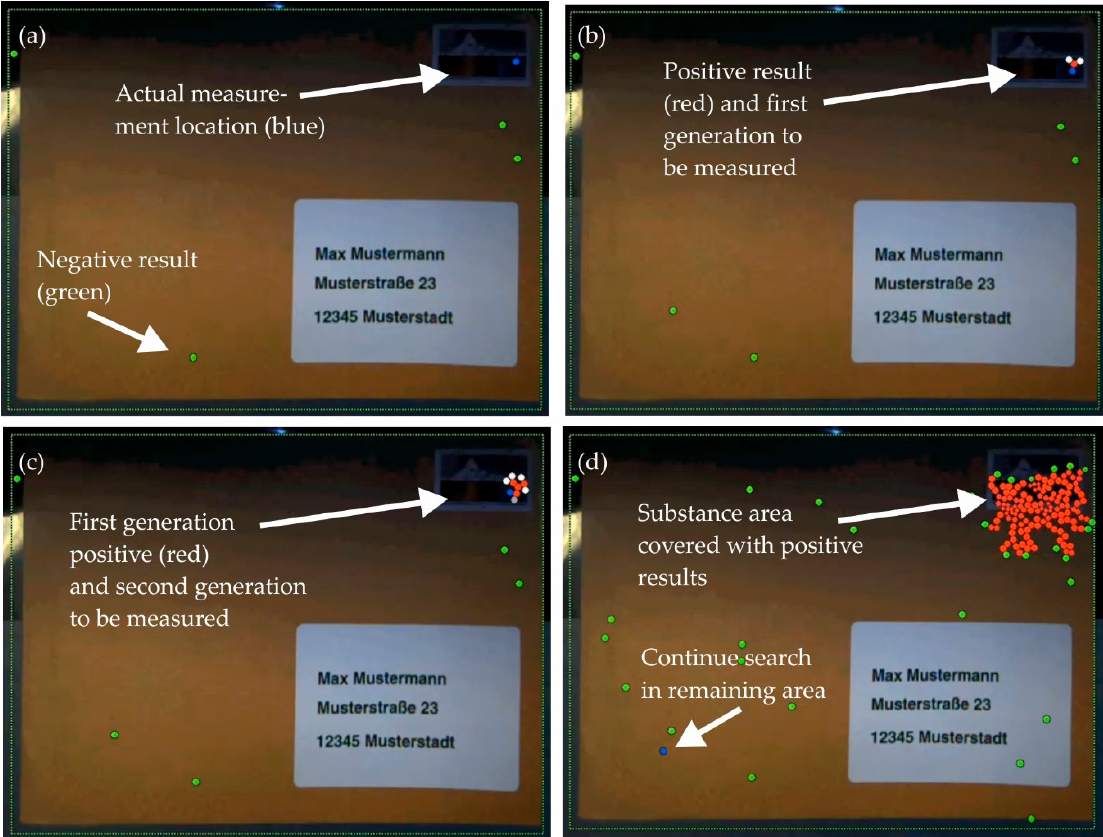
Figure 11. Procedure of result dependent search strategy. ( a ) First, random points on the sample surface are inspected. ( b ) In case of a positive result (red point upper right), new points (1st generation) are defined to be measured in the close vicinity. ( c , d ) This repeats with subsequent generations (e.g., lower left), until the area with substance is covered with measurement points (lower right). A full time-lapse video can be found at https://youtu.be/fc3DBzWsPDA.